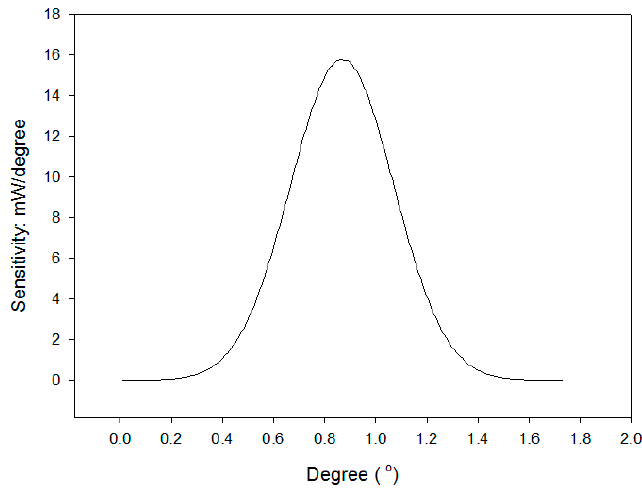
Figure 9. The sensitivity of experimental architecture ( σ is 0.976).